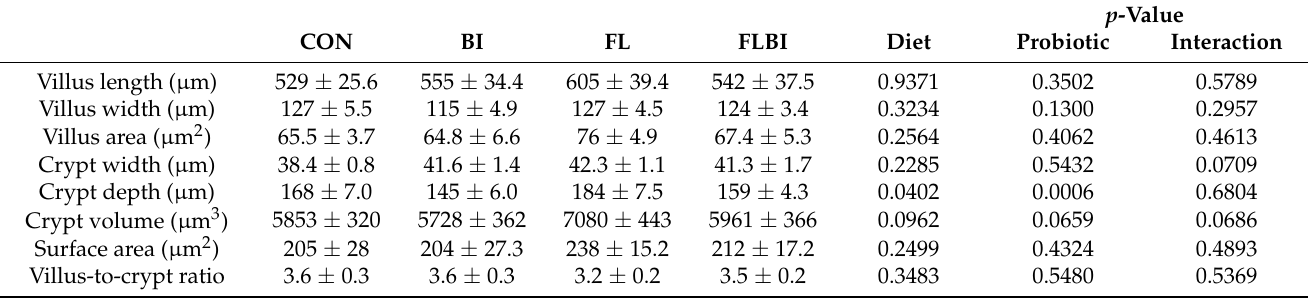
Table 2. Ileum Histomorphology.